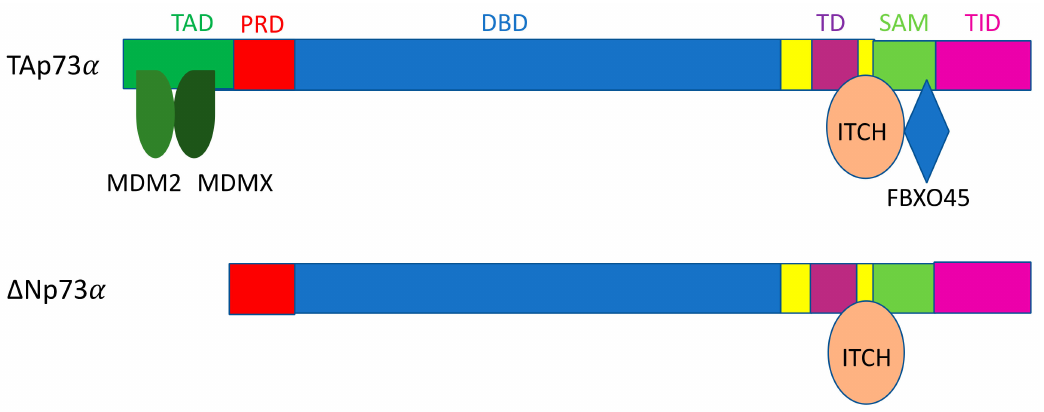
Figure 3. Schematic representation of interaction of p73 with di ff erent E3